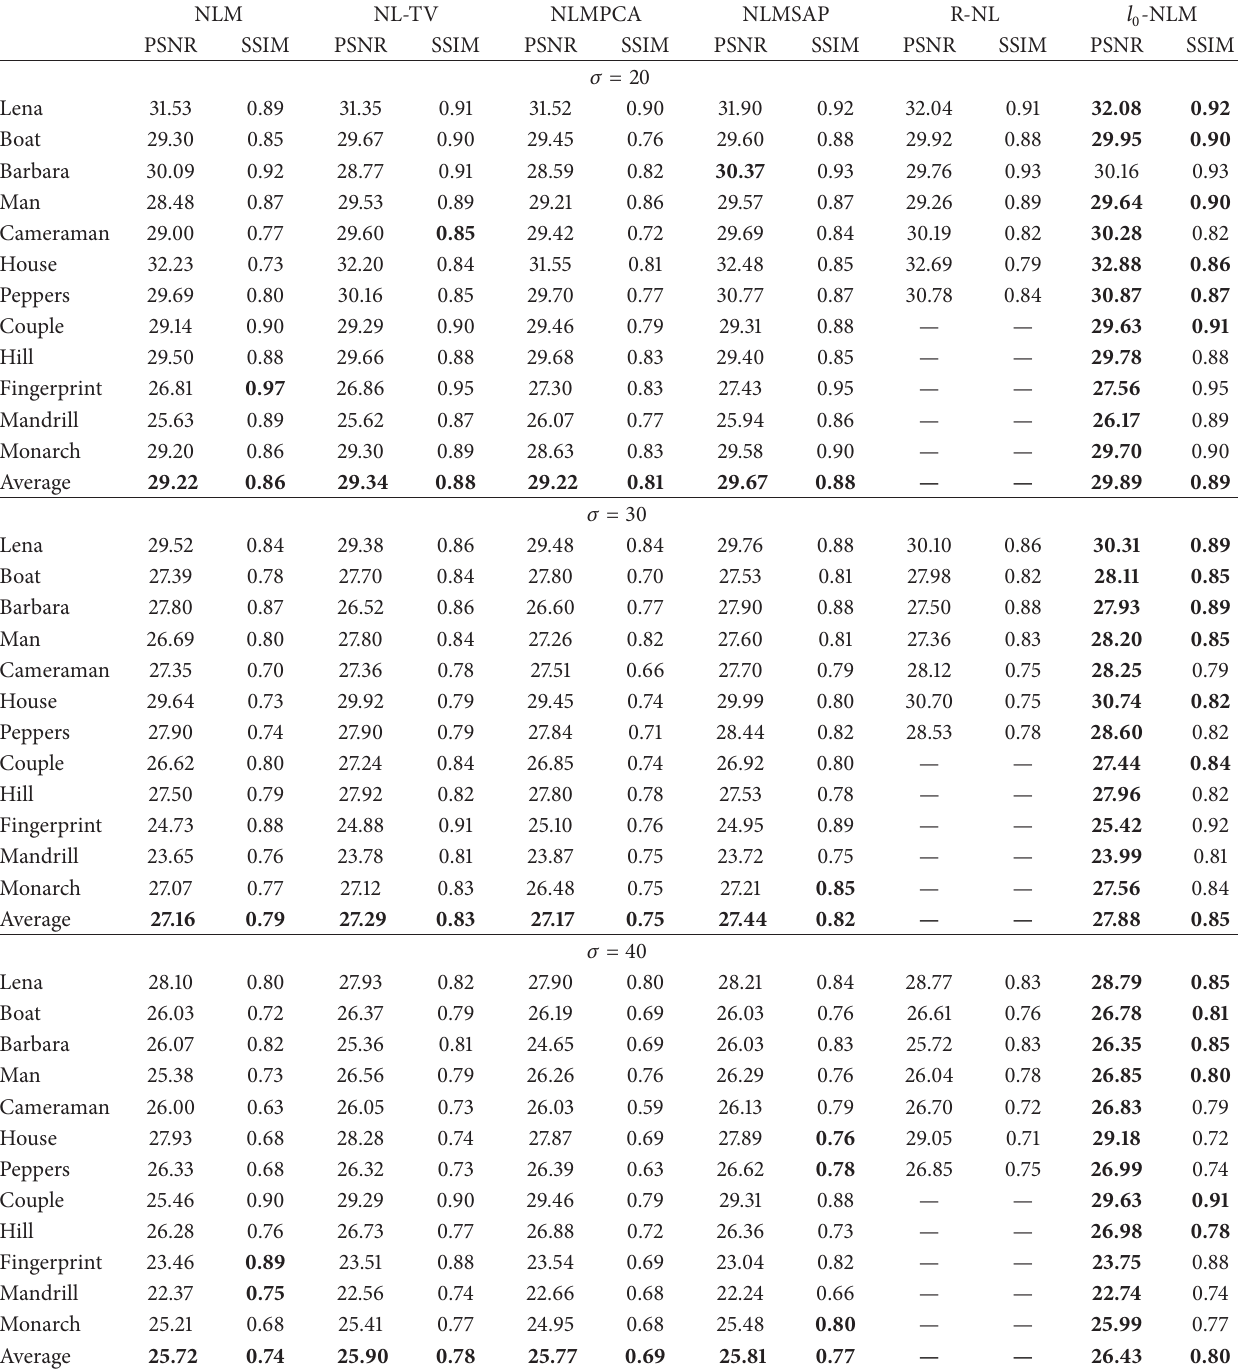
Table 1: PSNR/SSIM of denoising images using different models with 3 noise